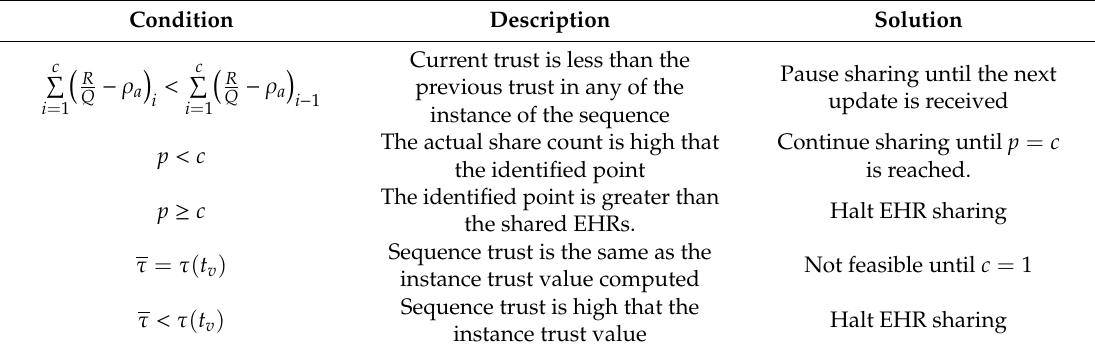
Table 2. Decision